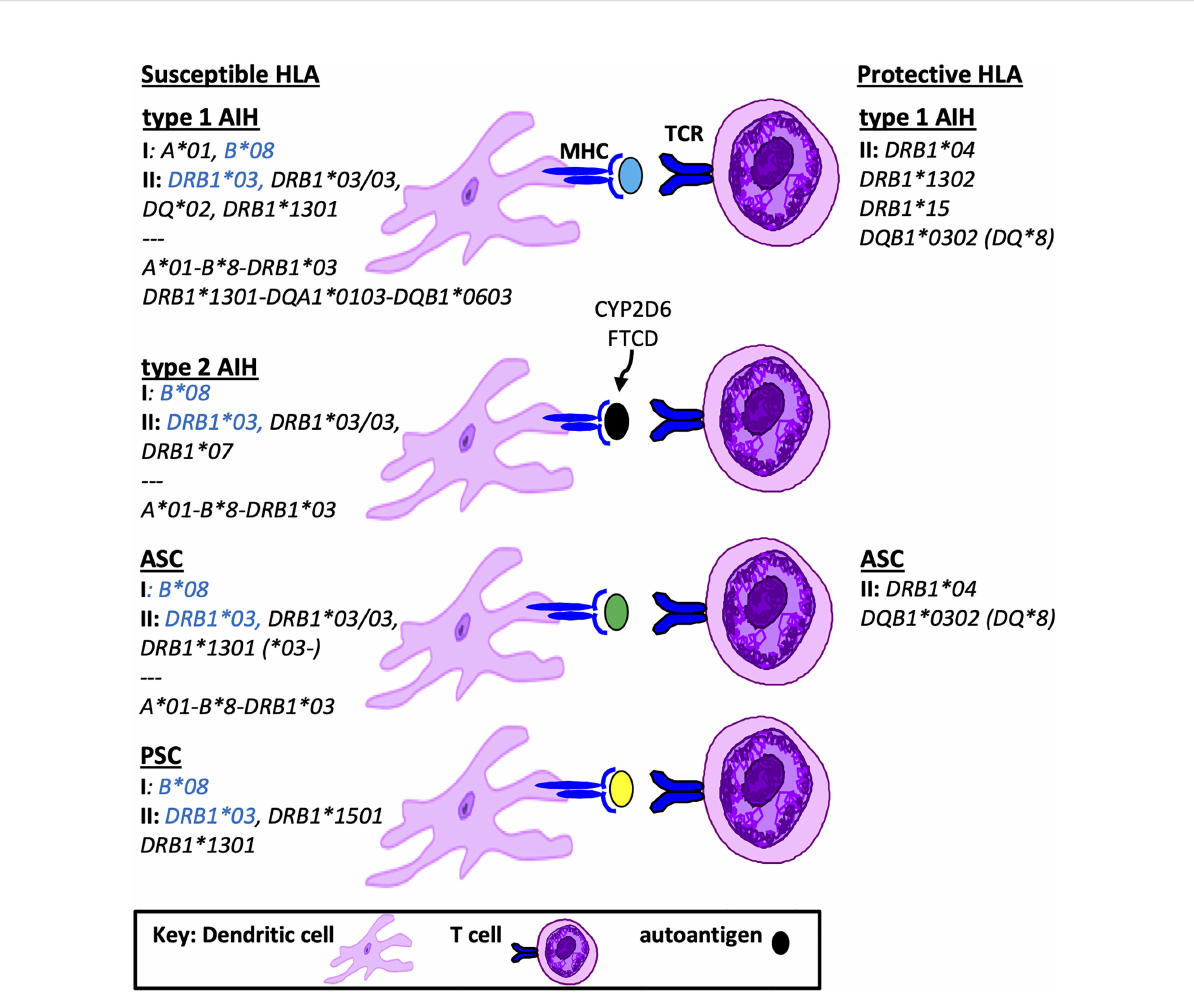
FIGURE 1 Susceptible and Protective HLA genotypes in Pediatric Autoimmune Liver Diseases. Shown is a summary of HLA genotypes associated with pathogenesis or protection from autoimmune liver diseases in children, including MHC class I, class II and grouped haplotypes based on linkage disequilibrium. Highlighted in blue are susceptibility HLA genotypes found in all pediatric